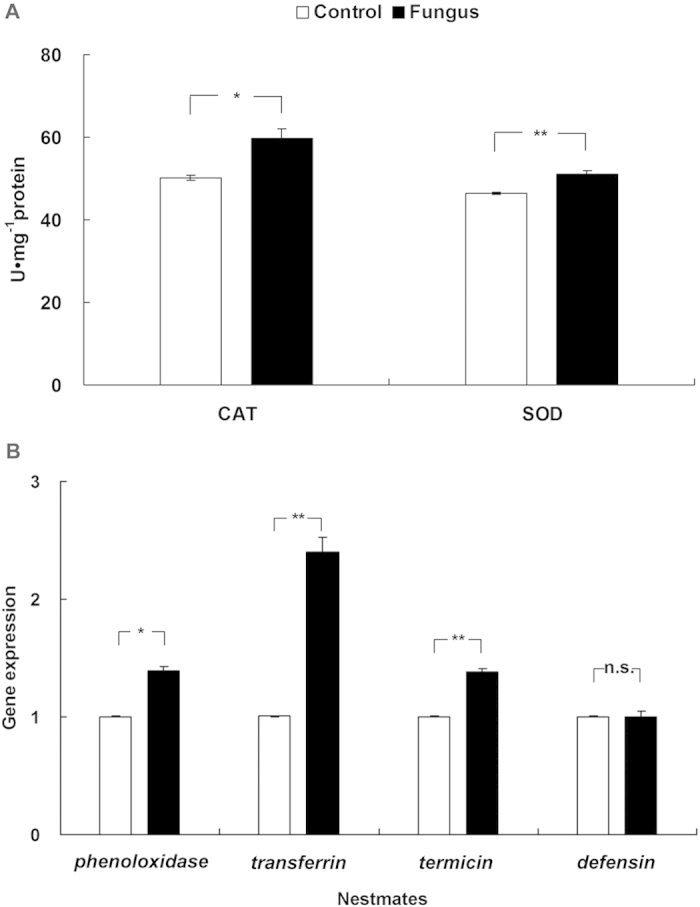
Activity of antioxidant enzymes and expression of immune genes in nestmates.(A) The activity of two antioxidant enzymes including catalase (CAT) and superoxide dismutase (SOD). (B) The expression of four immune genes including phenoloxidase, transferrin, termicin, and defensin. Error bars represent mean ± SEM. Asterisks denote significant differences between the nestmates of control-treated termites (white bars) and the nestmates of fungus-treated termites (black bars) after 5 d of social contact with treated termites. (*p < 0.05; **p < 0.01; n.s., not significant; paired t-test).